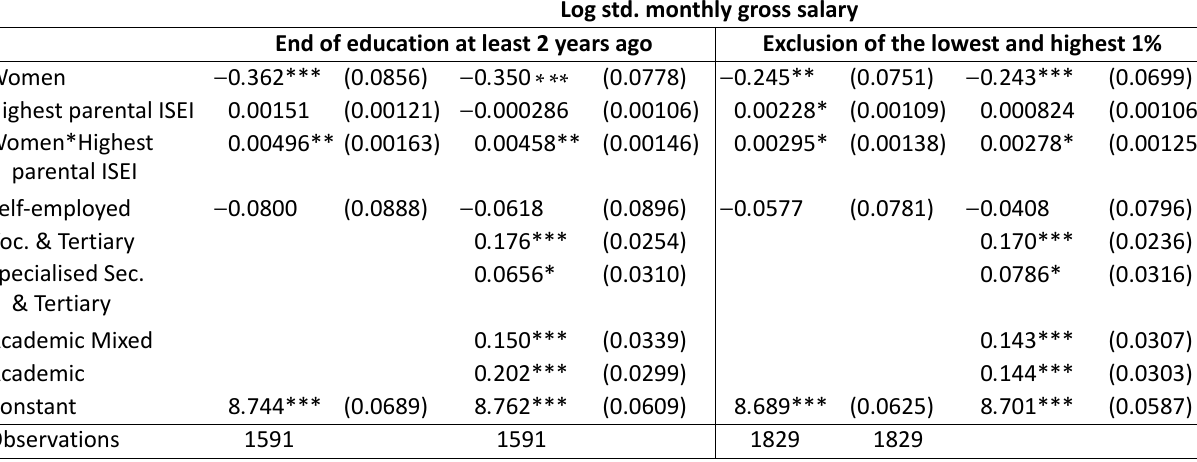
Table 10. Effects of educational clusters on social status and salary by gender (OLS coefficients). Source: PISA (2000) and TREE waves 1–9 (weighted;